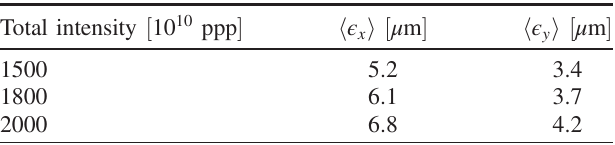
TABLE I. Measured average normalized emittance values for the MTE beam and different total intensities, expressed in protons per pulse (ppp). The emittance is expressed as 1 σ normalized value.